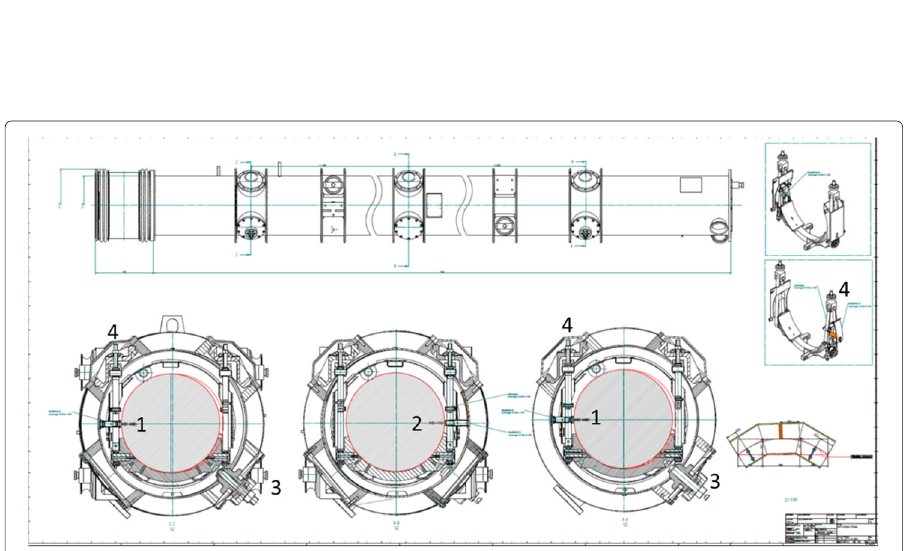
Fig. 13 Schematic view of the cryostat after the straightening. 1: Outer pressure prop, 2: Middle pressure prop, 3: Transportation fixture, 4: